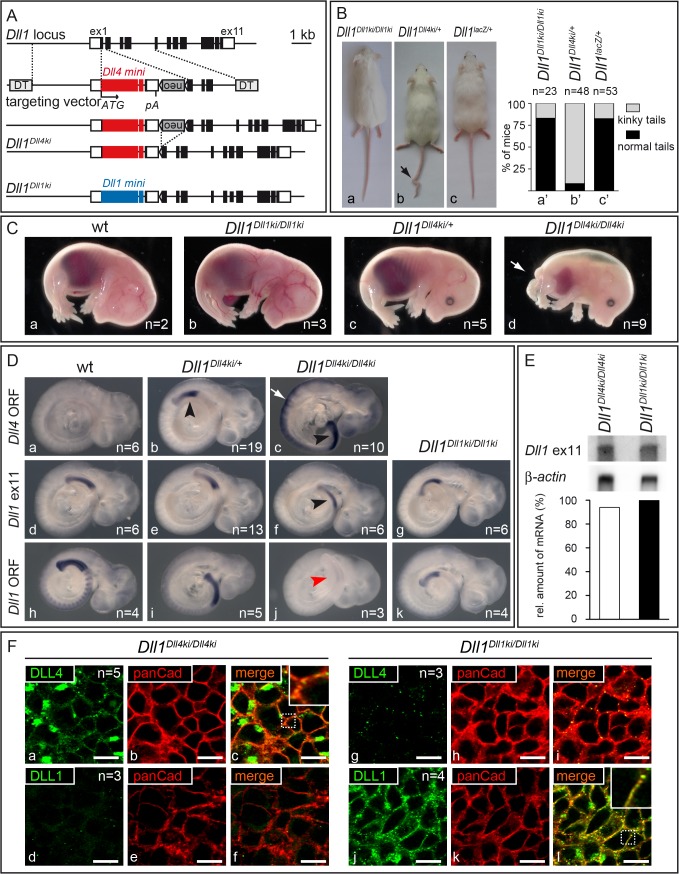
Generation of Dll1
Dll4ki mice that express Dll4 instead of Dll1 in the endogenous Dll1 domains.
(A) Targeting strategy to insert a Dll4 mini gene into the Dll1 locus. The Dll1 locus contains 11 exons depicted as black boxes (UTRs as white boxes). The targeting construct is comprised of the Dll4 mini gene [Dll4 cDNA from start codon (ATG) in exon 1 to exon 9 (large red box), Dll1 intron 9, Dll4 exon 10 (small red box), Dll1 intron 10 and Dll1 exon 11 that encodes only the terminal valine conserved between Dll1 and Dll4 followed by STOP codon and 3‘UTR], a floxed neo
r cassette, homology regions for integration between Dll1 start codon and exon 2, and flanking diphtheria toxin genes (DT); insertion of the mini gene is expected to disrupt expression of Dll1. neo
r is removed by Cre-recombination. The resulting Dll1
Dll4ki allele and the Dll1
Dll1ki control are shown below (blue boxes, Dll1 mini gene). (B) Heterozygous adult Dll1
Dll4ki mice frequently (89%) displayed a kinky tail (arrow in b) but looked otherwise normal. (C) Heterozygous E15.5 Dll1
Dll4ki foetuses (c) were indistinguishable from wildtype (wt; a) and homozygous Dll1
Dll1ki (b) foetuses while all homozygous Dll1
Dll4ki foetuses (d) displayed shortened body axes and large oedemas. (D)
Dll1 and Dll4 expression in Dll1
Dll4ki and Dll1
Dll1ki embryos visualised by whole mount in situ hybridisation of E9.5 embryos of the indicated genotype with a Dll4 ORF, Dll1 ex11 (recognises transcripts from both mini genes) and Dll1 ORF probe confirmed that Dll4ki alleles expressed Dll4 but not Dll1 in Dll1 expression domains (here the PSM, arrowheads). a-c were stained in parallel and colour development was stopped before endogenous Dll4 expression [49] and background became visible. Homozygous Dll1
Dll4ki embryos show strong expression in neuroectoderm (white arrow in c; not visible in the weaker staining with Dll1 ex11 probe in f). (E) Northern blot analysis of homozygous Dll1
Dll4ki and Dll1
Dll1ki E11.5 embryos, 2 μg polyA(+)-RNA loaded per lane, hybridised with 3‘UTR (Dll1 ex11) and β-actin probes; quantification of transgene signals relative to actin is shown at the bottom and indicates similar expression levels. (F) Visualisation of DLL1 and DLL4 expressed in the PSM of homozygous Dll1
Dll4ki (a-f) and Dll1
Dll1ki E9.5 embryos (g-l) using specific anti-DLL1 and anti-DLL4 antibodies. Co-staining with anti-panCadherin antibodies, which mark the plasma membrane, confirms that transgenic DLL4 and DLL1 predominantly localise to the cell surface (c,l). The lack of DLL1 signal in Dll1
Dll4ki (d) and of DLL4 signal in Dll1
Dll1ki PSMs (g) confirm the specificity of stainings. Both in anti-DLL4 and anti-DLL1 antibody stainings of PSMs, we observed spots of high signal intensity that may result from accumulation of ligands at these sites and that had also been observed in wildtype PSMs stained with anti-DLL1 antibodies [21]. Scale bars, 10 μm; insets show magnifications of the dotted boxes in c,l.